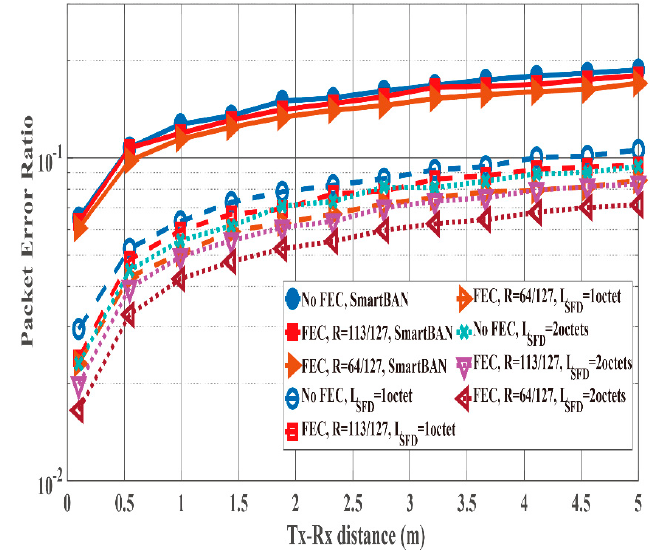
Figure 16. PER performance as a function of the Tx-Rx distance. Cases without and with SFDs ( L SFD = 1 octet and 2 octets).